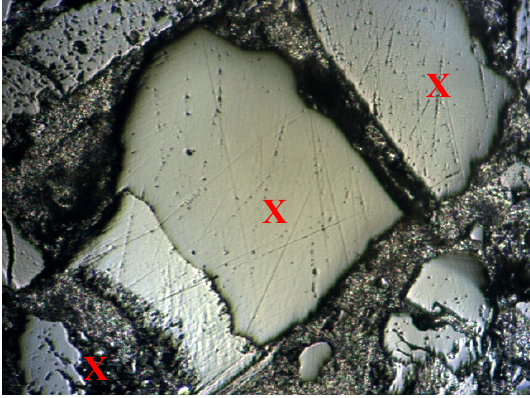
Figure 1. Indentation sites for Set 1 (marked with X).